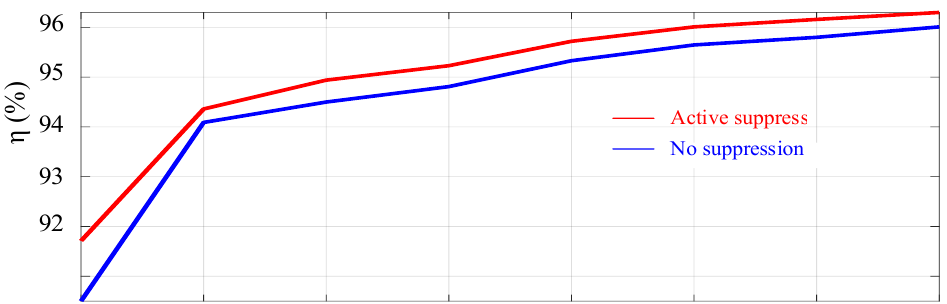
Figure 17. Harmonics spectrum of the transformer voltage in the TAB converter. The efficiency curve of the DAB prototype is shown in Figure 18, where V P1 = V P2 = 220 V. When the HFO was suppressed, the efficiencies were increased by 0.3~0.4% after the SHE PS modulation method was utilized.